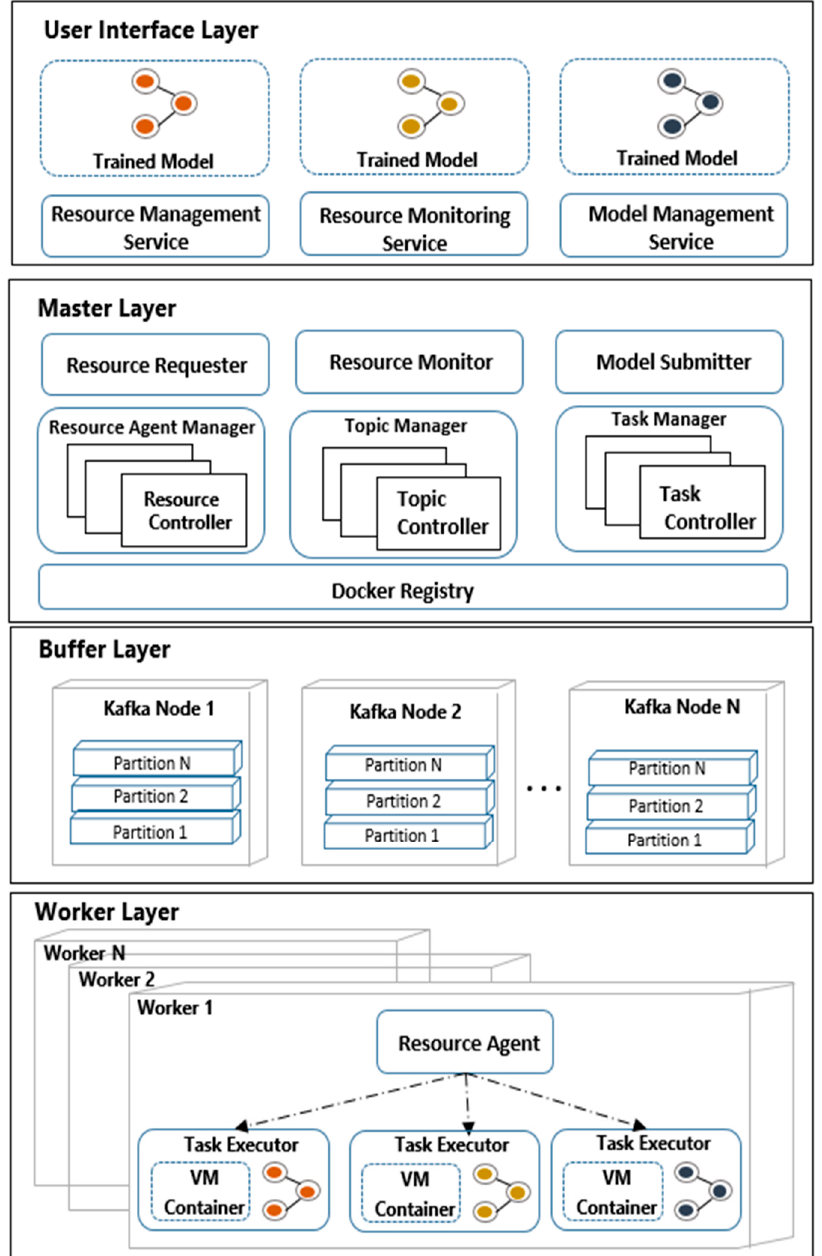
Figure 2. Overall architecture of DiPLIP.